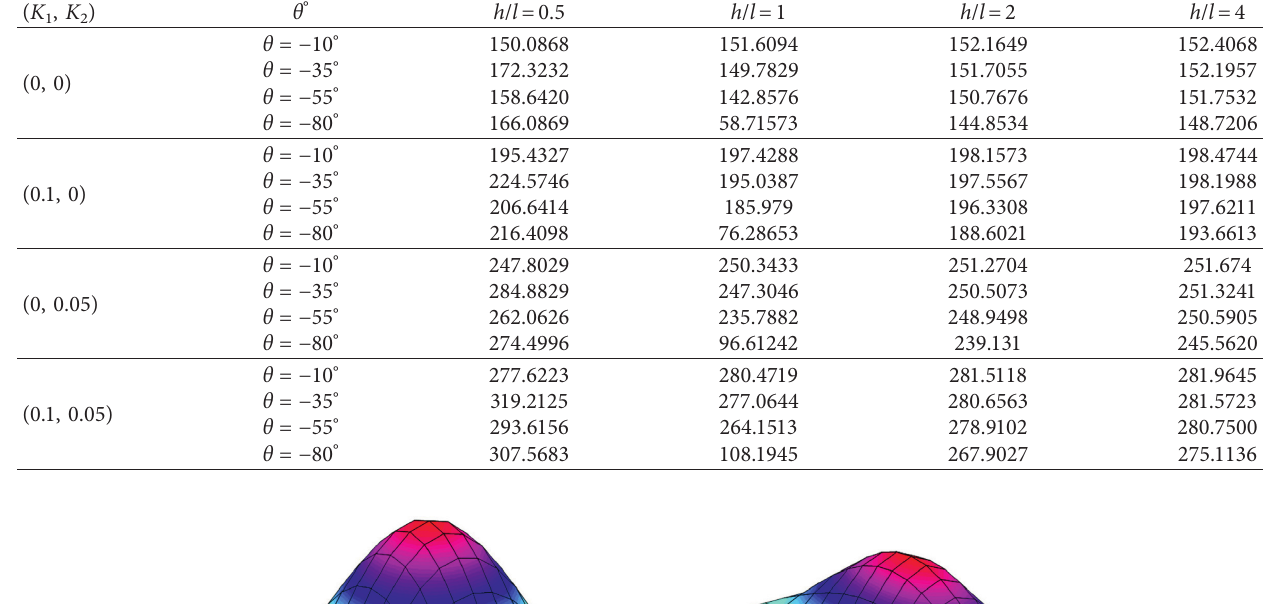
Table 4: The first natural frequencies (Hz) of the plate with different values of the EF parameters and geometry parameters of the core layer